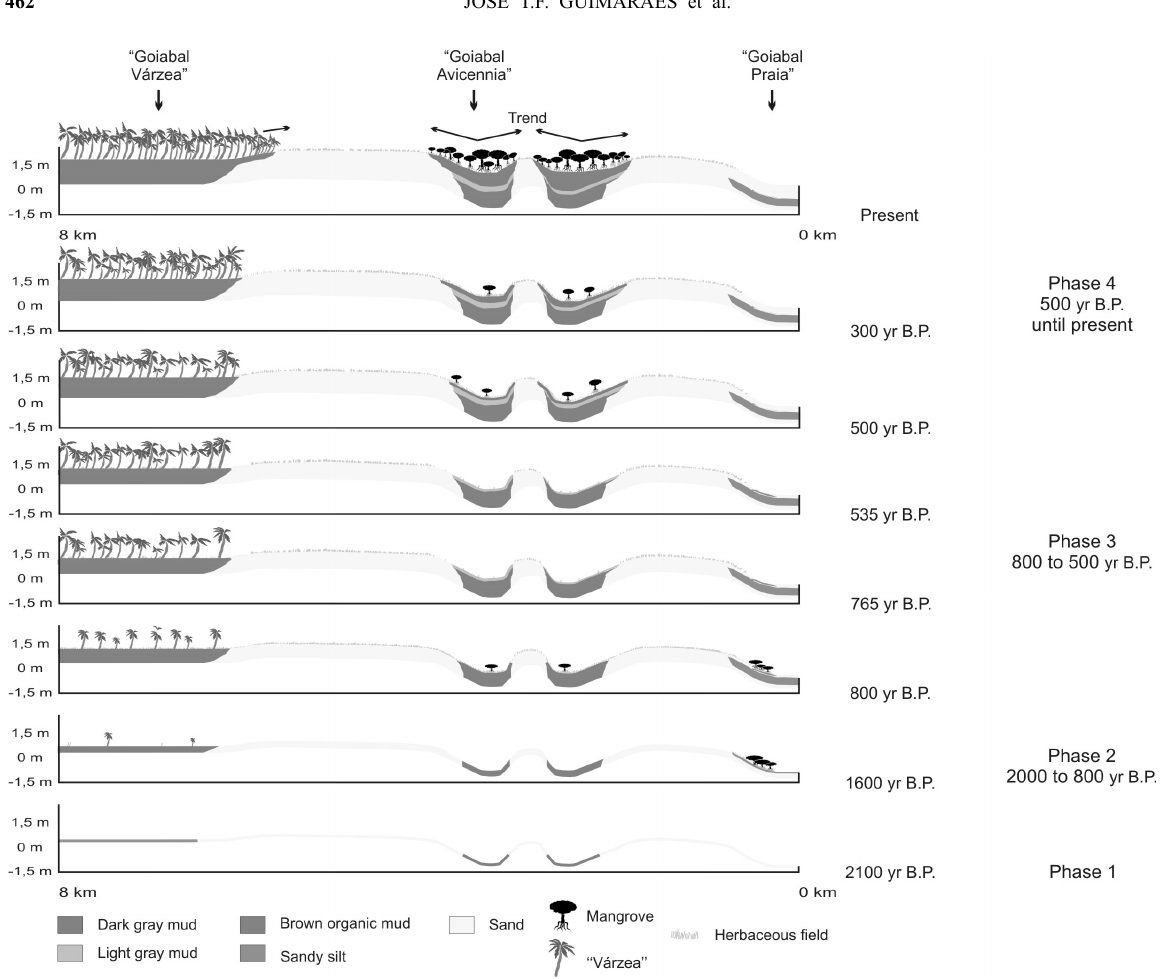
Fig. 5 – Model of wetland development in the Calçoene coastal